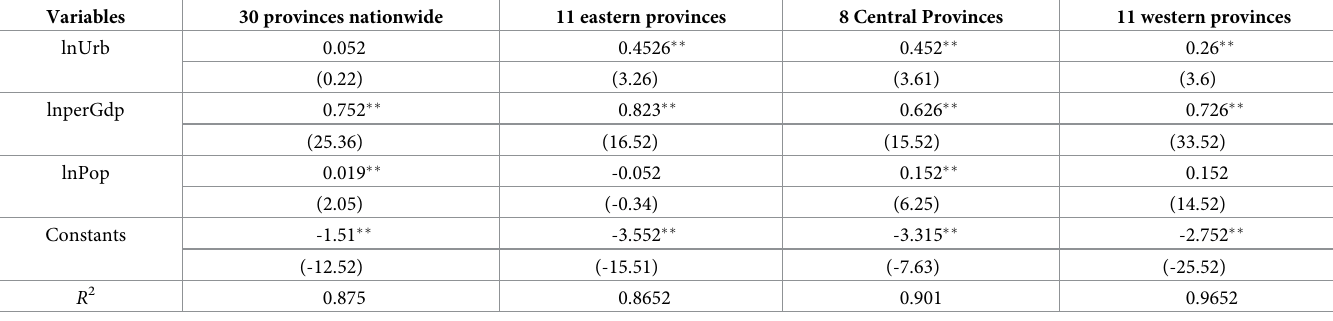
Table 8. GMM estimation results of the residential indirect energy consumption model.